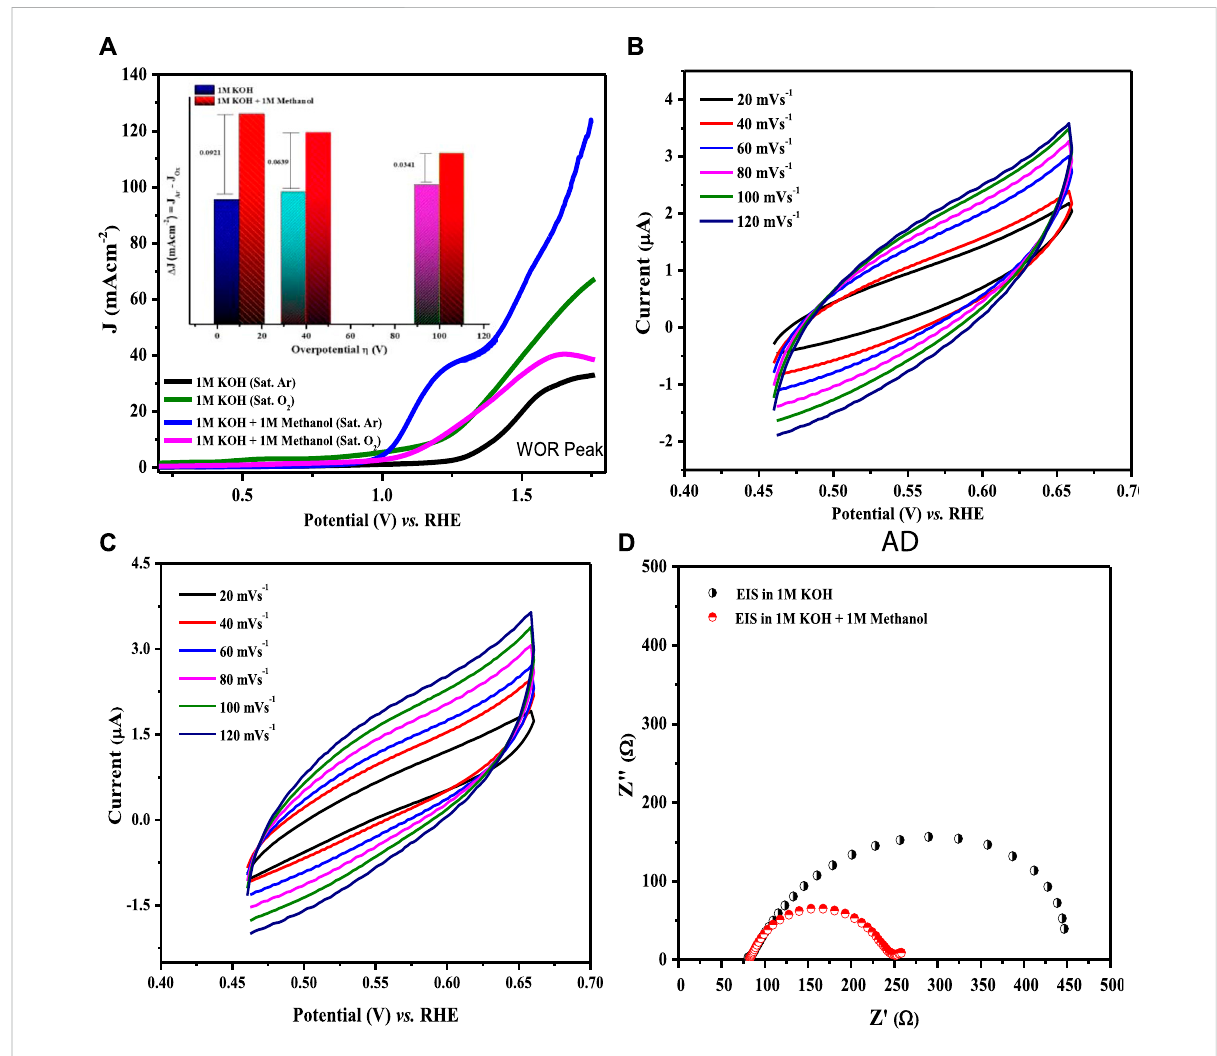
FIGURE 12 (A) LSV scans for water oxidation at 20 mV s − 1 in KOH, KOH/methanol mixture in oxygen- and argon-saturated environments using LCNiO-9- modi fi ed GC. The inset presents the difference of current densities in argon- and oxygen-saturated environments. (B,C) CV plots at different